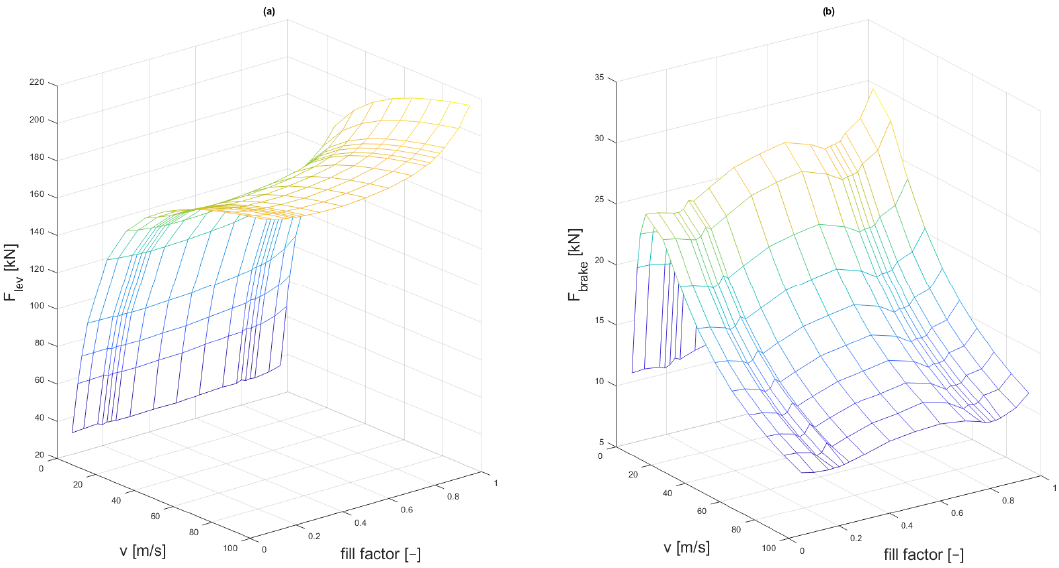
Figure 7. ( a ) Rescaled levitation force as a function of velocity and fill factor and ( b ) rescaled braking force as a function of velocity and fill factor.